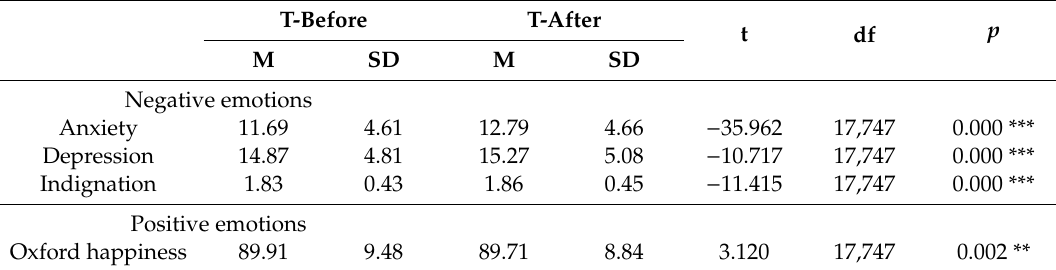
Table 3. Emotional indicators before and after 20 January.